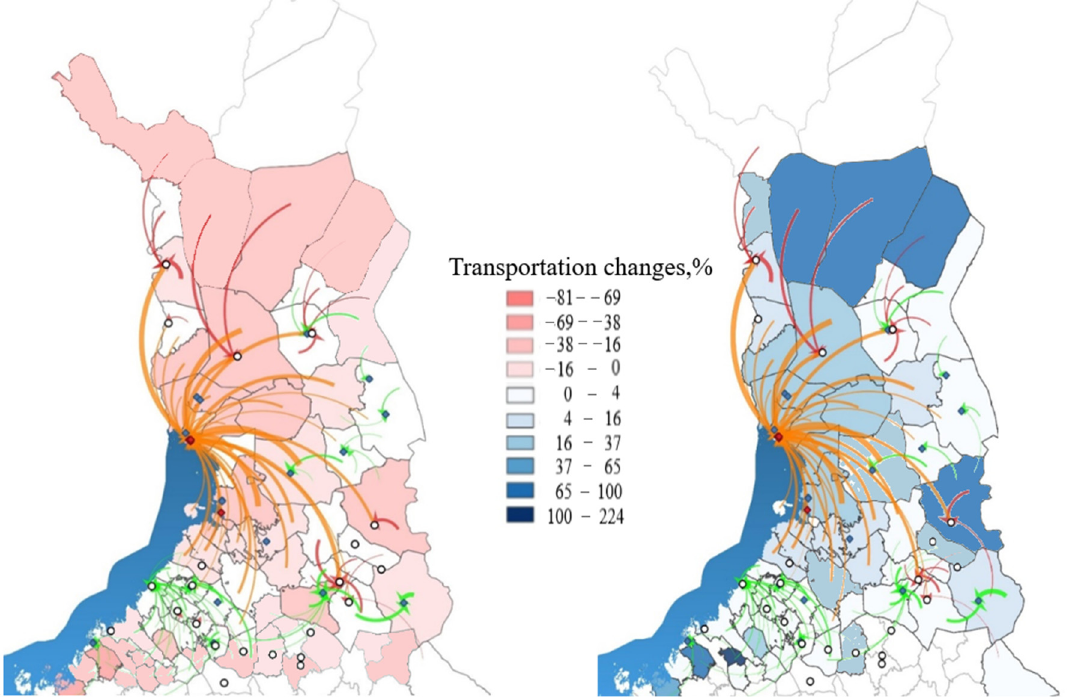
Figure 8. Pine log long-distance transport by Scenario 1 ( left ) and Scenario 2 ( right ). The thickness of the arrow describes the amount of transport. The orange arrow depicts deliveries to sawmills of the experiment, the red arrow to railway stations, and the green arrow to factories of other companies. The red–blue color scale of the municipalities describes transport logistics changes from the baseline scenario.